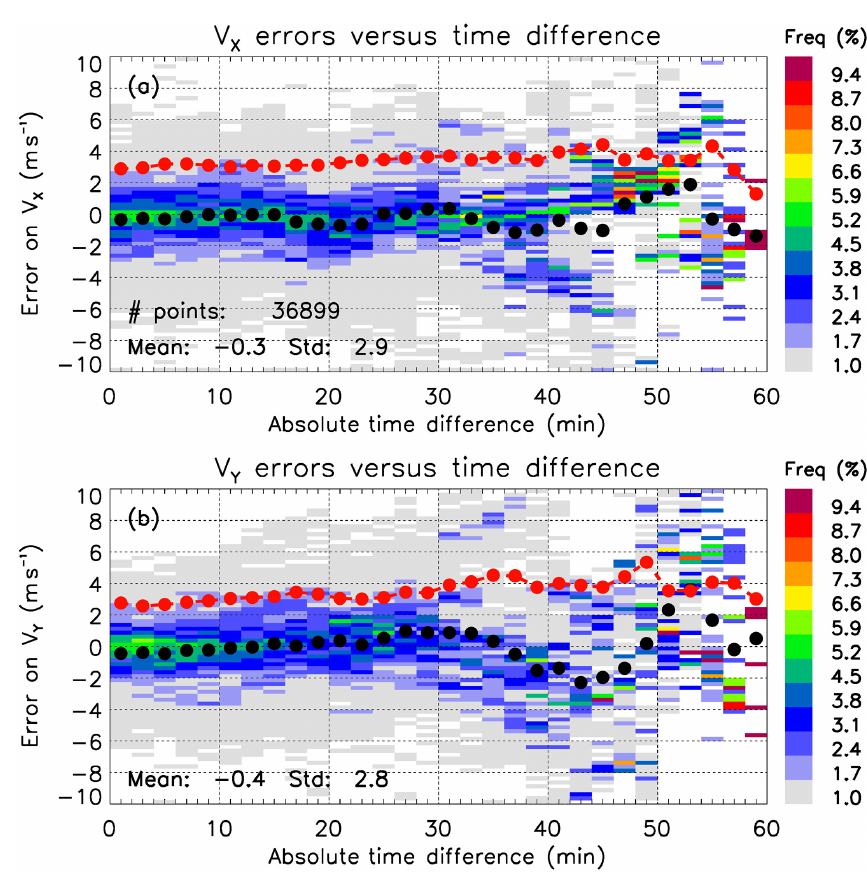
Figure 9. Same as Fig. 8 but using bins of absolute time difference between retrievals and radiosonde